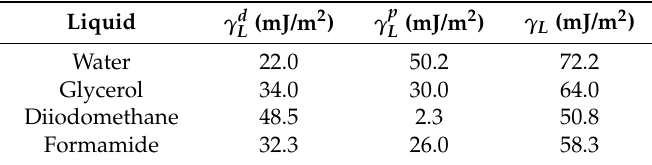
Table 1. Characteristics of the different employed test liquids.